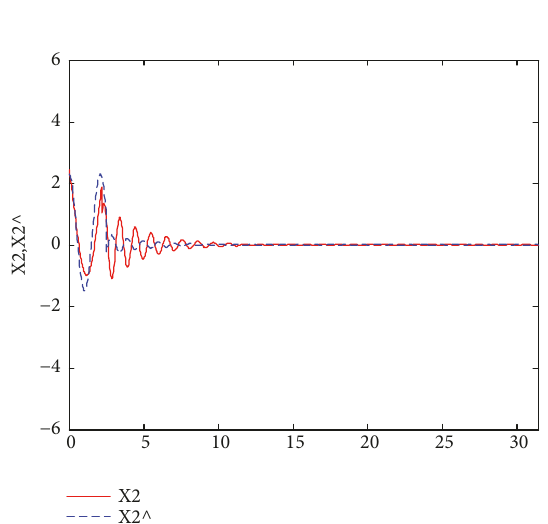
Figure 5: System states and ESO outputs of 𝑥 3 .